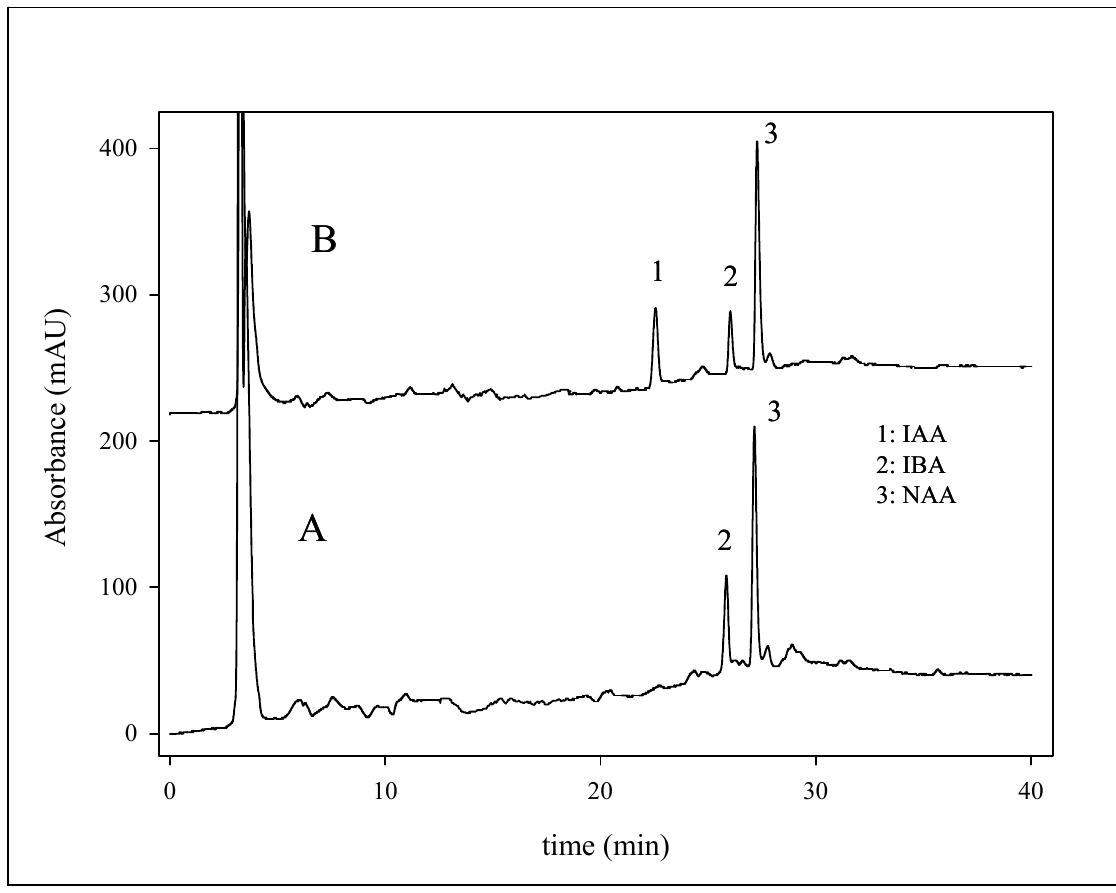
B shows analysis of the eightfold diluted gelastin A with standard addition of IAA and NAA (0.5 µg to one mL of the diluted sample). Chromatographic conditions were as follows: column: Polaris C , mobile phase: Table 1, flow rate: 200 µL·min -1 , temperature: 18 50 °C, wavelength: 210 nm, sample injection: 20 µL.